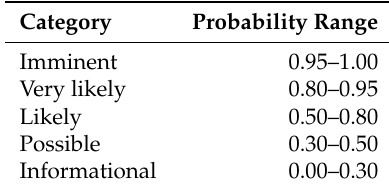
Table 2. Subjective assessment of likelihood.